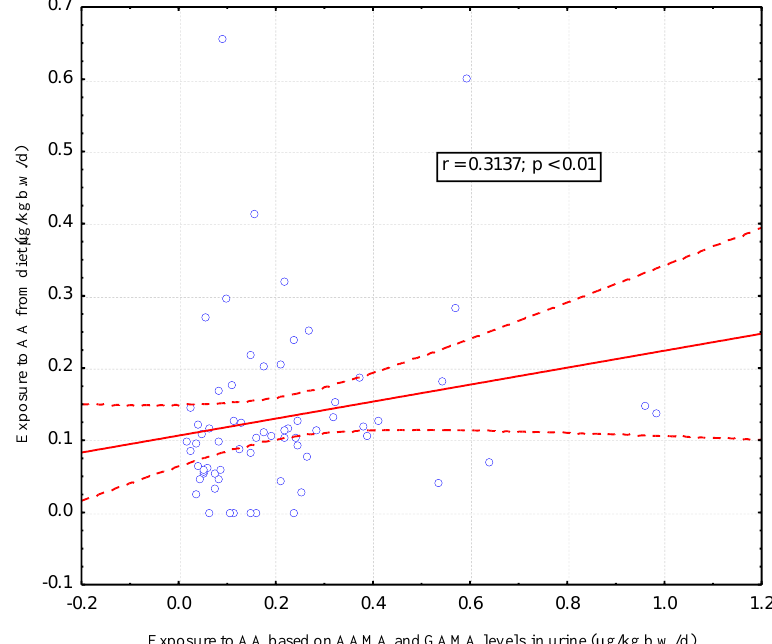
Figure 2. Correlation between acrylamide exposure estimated based on a 24-h dietary recall and AAMA and GAMA levels in urine after childbirth in a group of non-smoking women (n = 67).